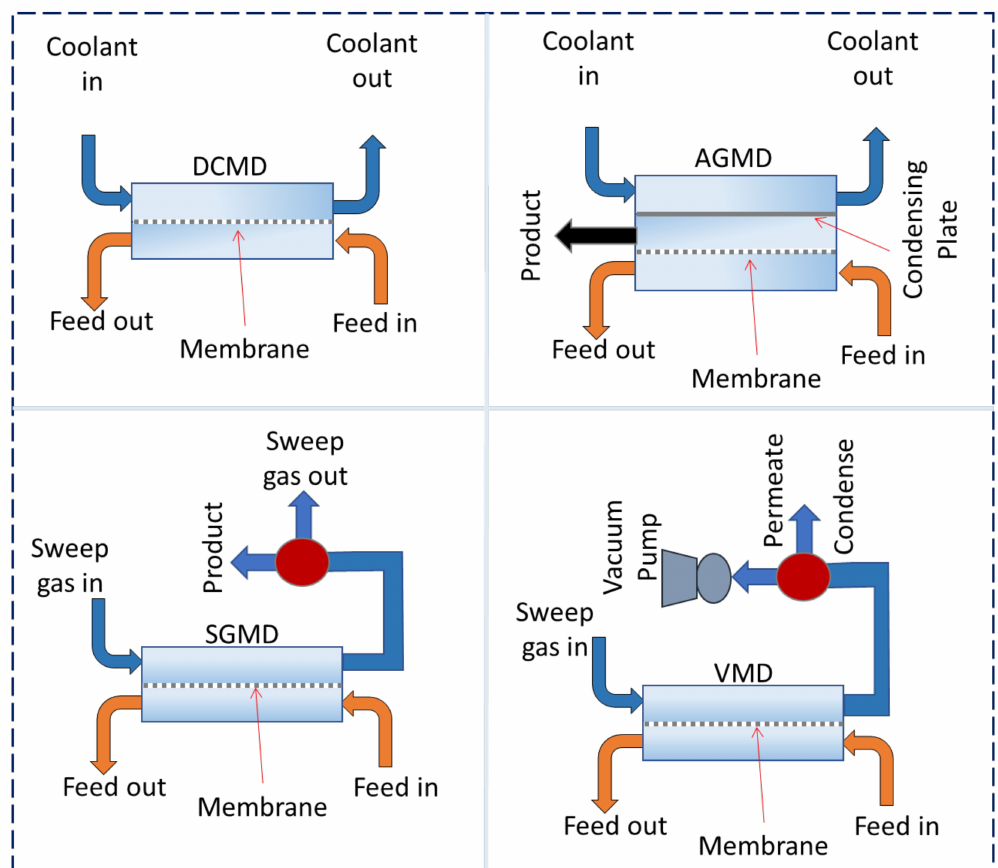
Figure 1. Schematic view of different MD processes: DCMD, AGMD, SGMD, and VMD